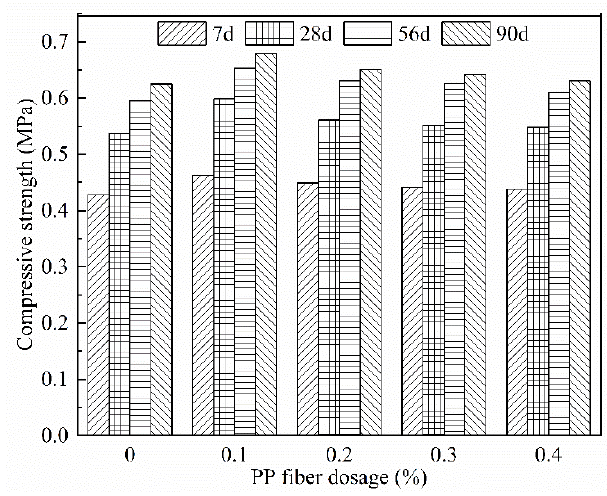
Figure 6. Effect of PP fiber dosage on compressive strength at different ages.